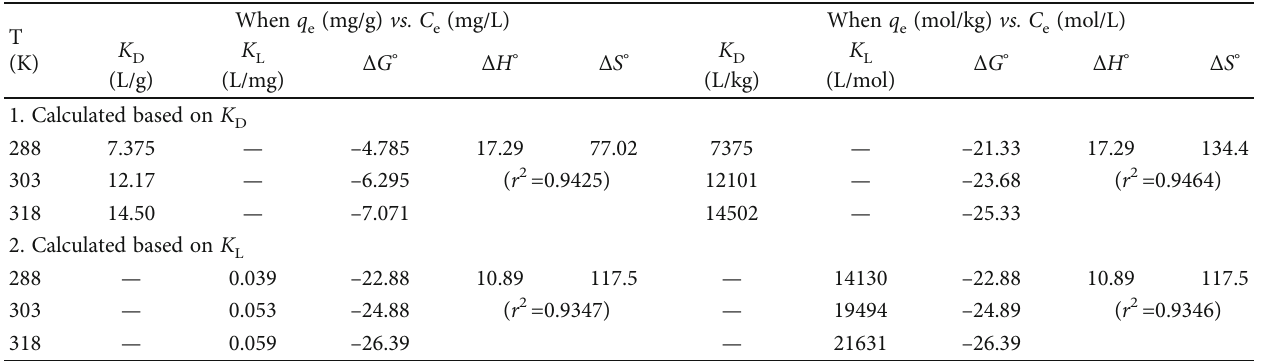
and K . D L (mol/kg) vs. C e e